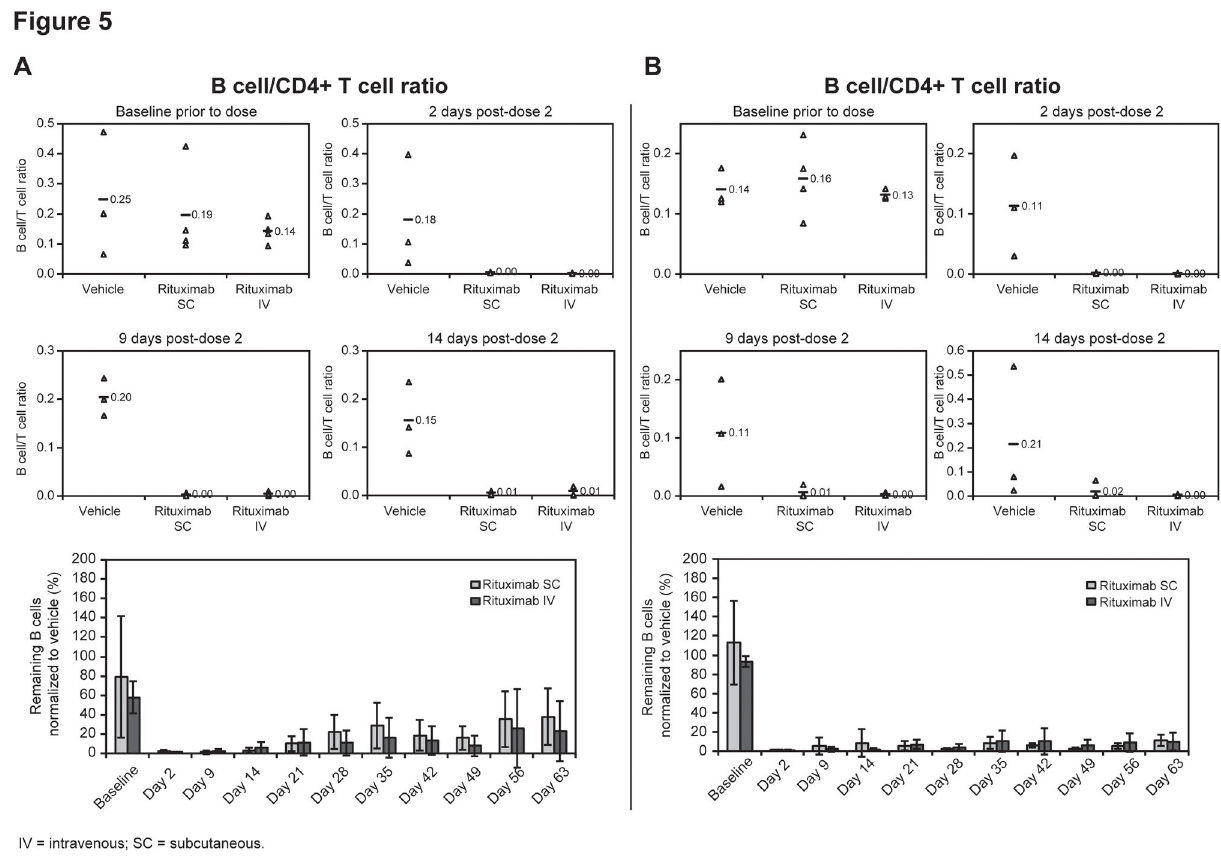
Figure 5. Depletion of Peripheral Blood CD21+ and CD21- B-cell subsets. Short and long-term analysis of PBMC B-cell depletion of ( A ) CD21+ and ( B ) CD21- B-cell subsets (as identified in Figure 2C). Individuals animal samples with mean shown for baseline, day 2, day 9 and day 14 post second dose (top) and percent remaining as normalized to PBS vehicle treated group (bottom) (group mean ± SD (n=4 rituximab treated groups, n=3 PBS vehicle treated groups).